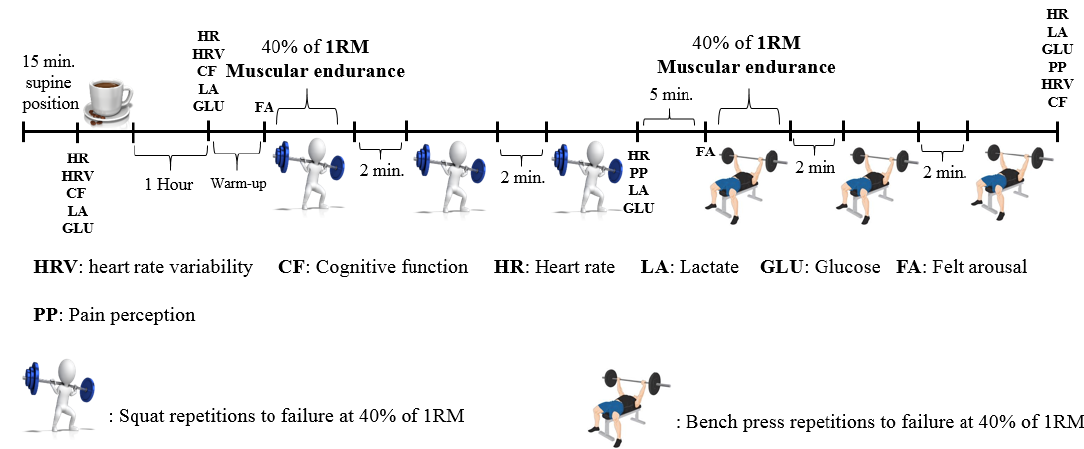
Figure 1. A schematic of the experimental